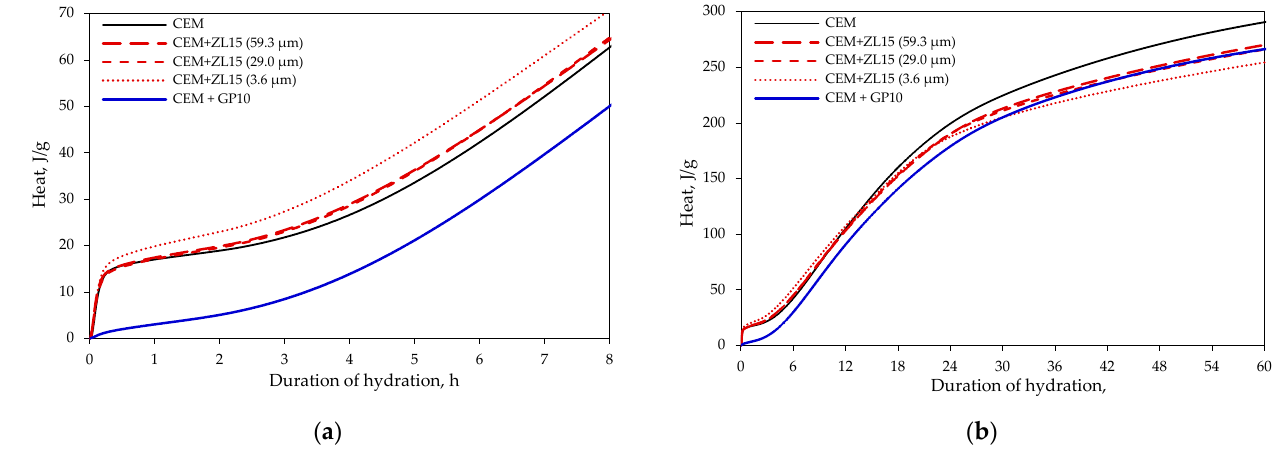
Figure 5. The amount of released heat: ( a ) 8 h of hydration; ( b ) 60 h of hydration.